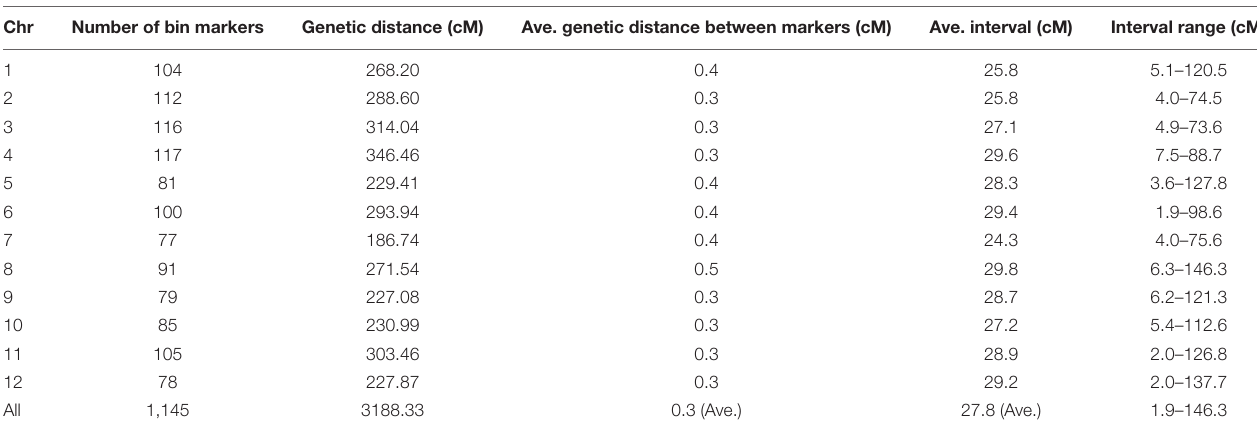
TABLE 1 | Summary of genetic linkage map characteristics in